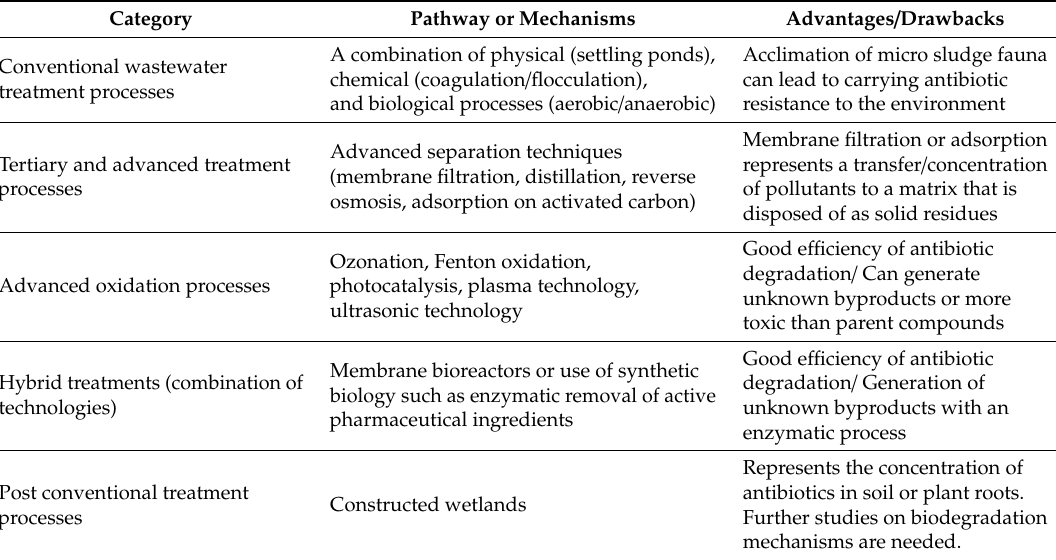
Table 2. Categorization of treatment processes (adapted from references